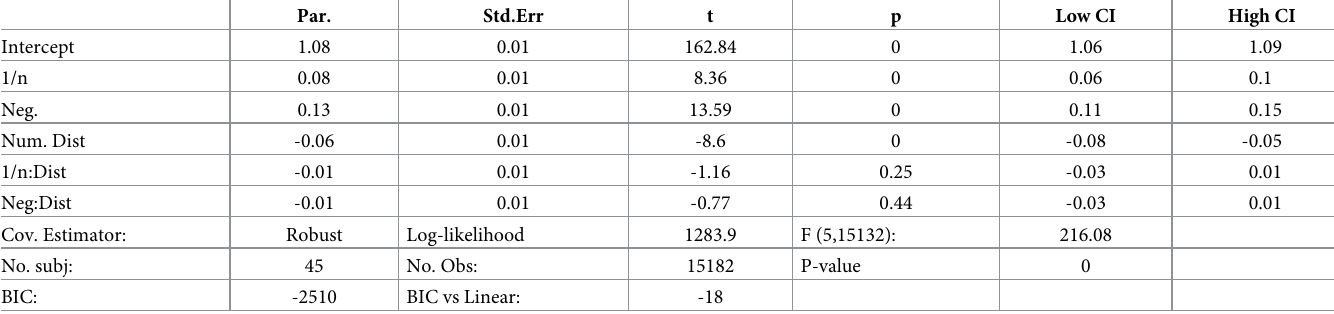
Table 3.4. RT. Exp. 3 . Fixed Effects Estimation Summary.